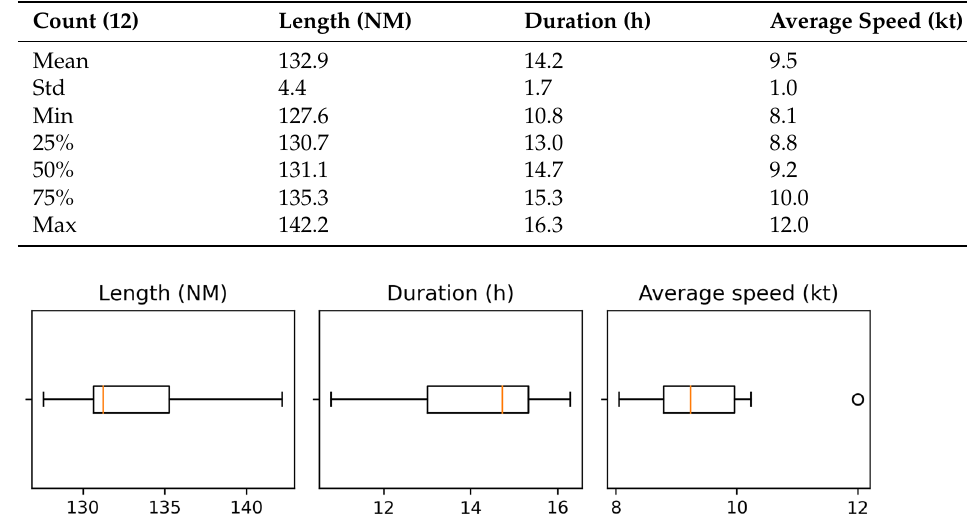
Figure 4. Boxplots for voyage length (NM), duration (h) and average speed (kt).